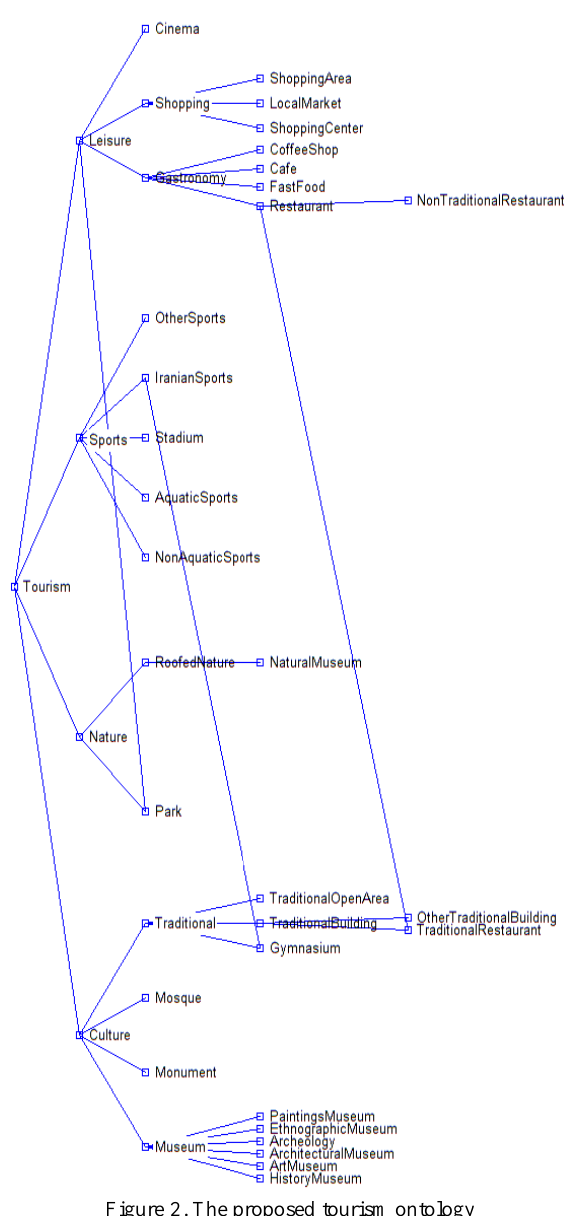
Figure 2. The proposed tourism